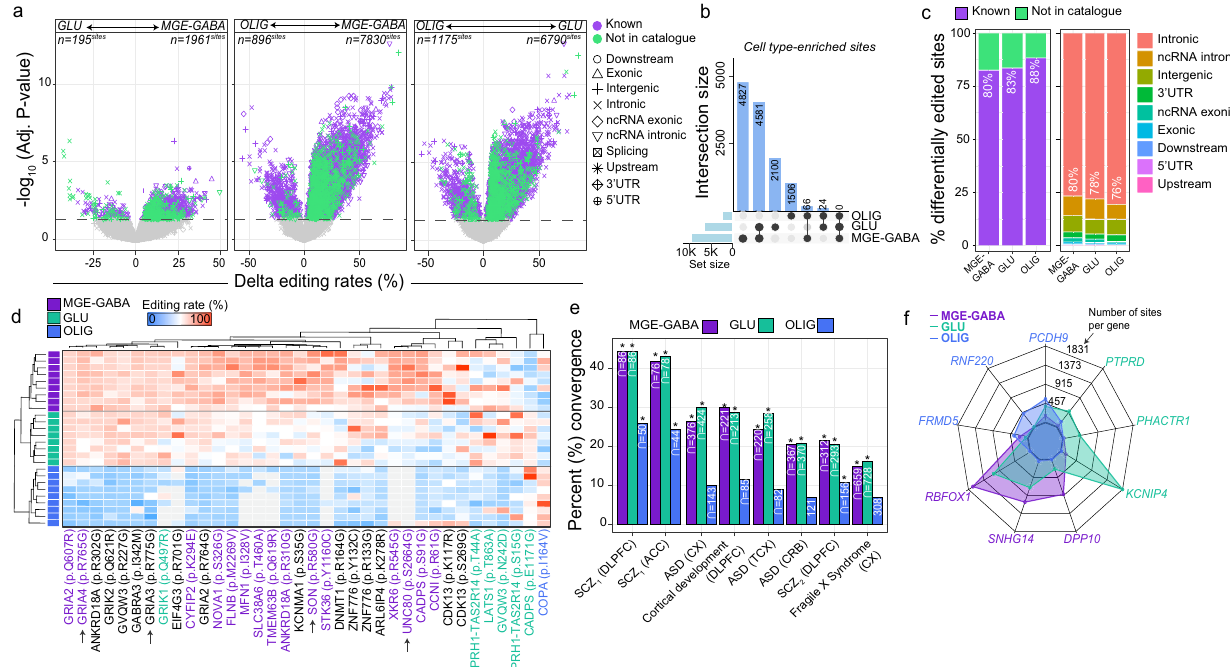
Fig. 3 Cell type differential editing, recoding sites and gene-level enrichment. a Differential RNA editing compared GLU vs. MGE-GABA (left), OLIG vs. MGE-GABA (center), and OLIG vs. GLU (right) ( n = 9 biologically independent samples per cell type). Change in editing levels (%, x-axis) compared to the strength of signi fi cance ( − log 10 Adj. p value). The horizontal axis marks an adjusted p value of 0.05. RNA editing sites are uniquely shaped by the genic region and colored by catalog annotation. b UpSet plot reporting counts for all cell type-enriched sites are reported with their overlaps. c The percentage (%, y-axis) of differentially edited sites by catalog annotation (left) and genic region (right). d Heatmap displaying differential editing levels at recoding sites across MGE-GABA (blue), GLU (purple), and OLIG (green) cells. The gray color indicates sites that were not detected in a given sample. Arrows (x- axis) indicate sites validated by independent methods (Supplementary Fig. 9). e The percentage of previously reported altered editing sites in bulk brain tissues with cell type-associated features (%, y-axis). Dysregulated RNA editing sites in bulk brain tissue were collected from the dorsolateral prefrontal cortex (DLPFC), anterior cingulate cortex (ACC), cortex (CX), temporal cortex (TCX), cerebellum (CRB), schizophrenia (SCZ; SCZ 1 CommonMind Consortium; SCZ 2 NIMH HBCC cohort), autism spectrum disorder (ASD), cortical development (Hwang et al., 2016). One-sided Fisher ’ s exact test and an estimated odds ratio was used to compute the signi fi cance of each overlap and a p value <0.05 (*) was deemed signi fi cant. Exact p values for all tests are reported in Supplementary Data 4. f Spider plot of the top three genes for each cell type that displays enrichment for RNA editing sites after accounting for gene